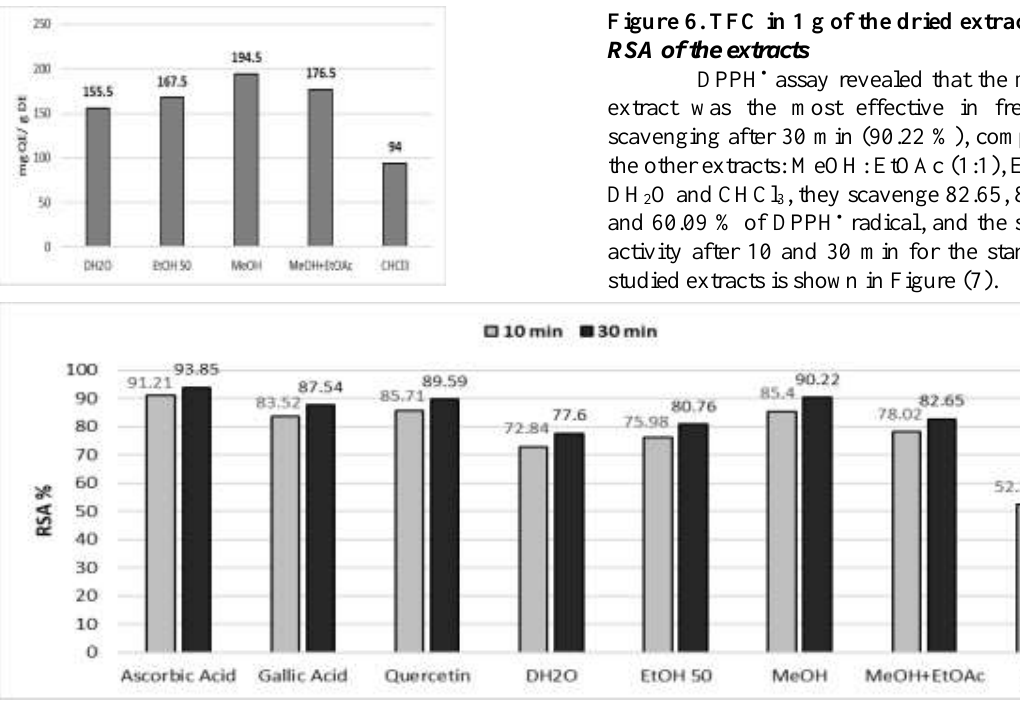
All results of TFC are presented as the mean of three replicates ± SD ( p < 0.05)